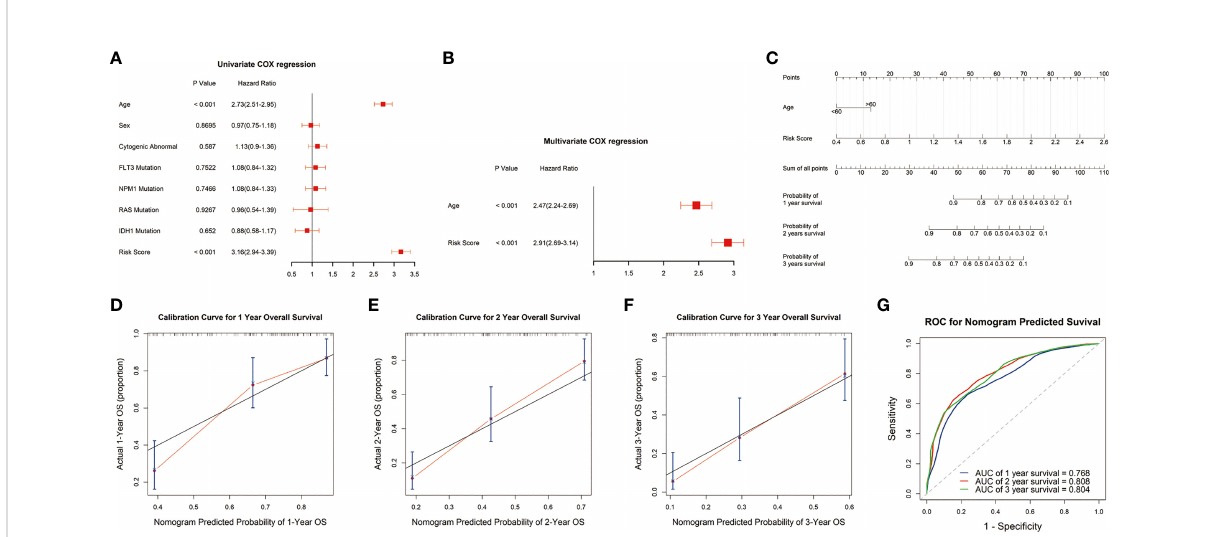
FIGURE 4 Construction and validation of the nomogram. (A, B) Univariate and multivariate analyses showed that risk score was an independent prognostic factor in the TCGA cohort. (C) Nomogram consisting of risk score and age. (D-F) Calibration plots of the nomogram to predict the probability of survival and actual survival rates at 1-, 2-, and 3-year in the TCGA cohort. (G) ROC curve to predict 1-, 2-, and 3-year survival for the nomogram in the TCGA